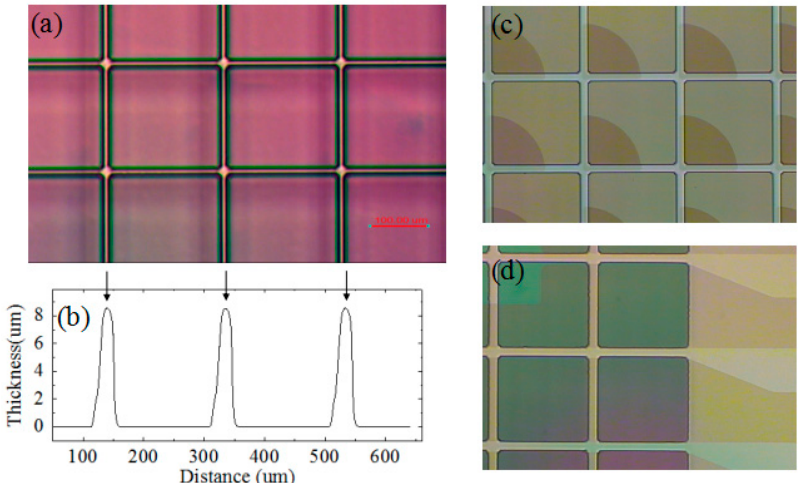
Figure 3. ( a ) Optical microscope photograph and ( b ) morphology data measured by stylus profiler of pixels as an example of the photoresist pattern; ( c , d ) Examples of patterning photoresist onto fluoropolymer surface with substrates of various indium tin oxide (ITO) designs.